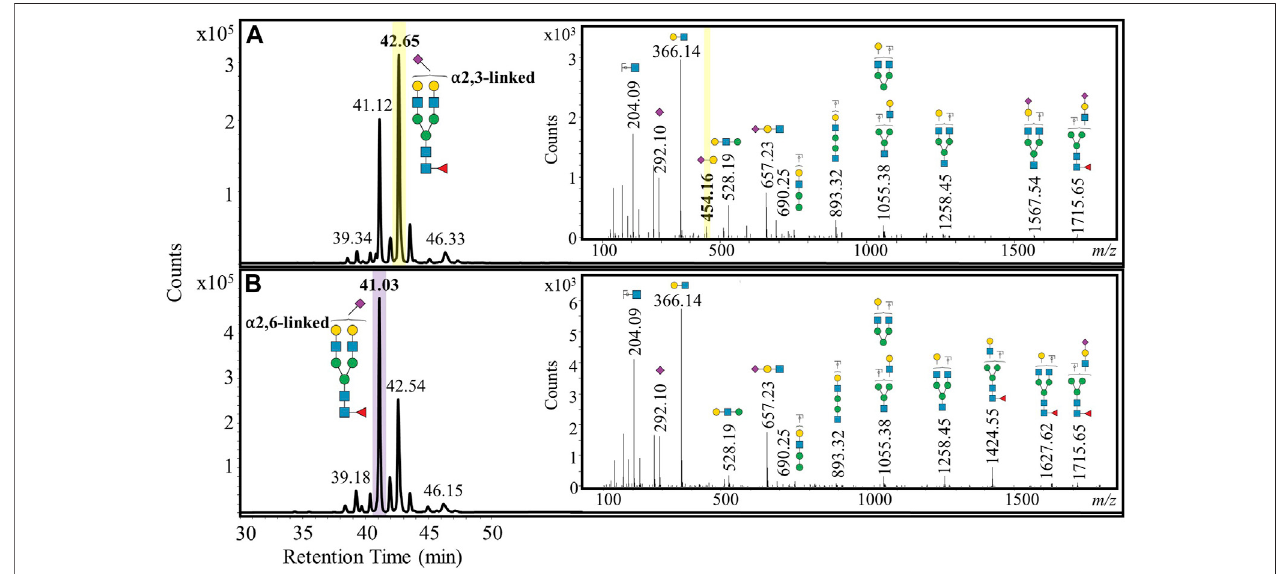
FIGURE 4 | Representative extracted ion chromatograms of a doubly positively charged monoisotopic species ( m/z 1040.89), which was identi fi ed and characterized as a fucosylated bi-antennary complex N- glycan that wassingly sialylated. The sialylation was predominantly α 2,3-linked for late-stage ovarian cancer (A) and α 2,6-linked for early-stage ovarian cancer (B)